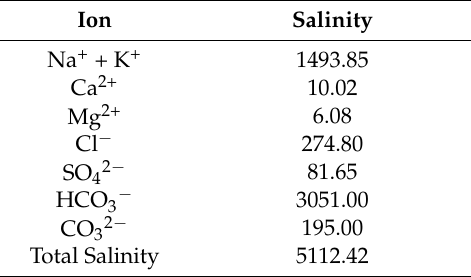
Table 2. Formation water composition